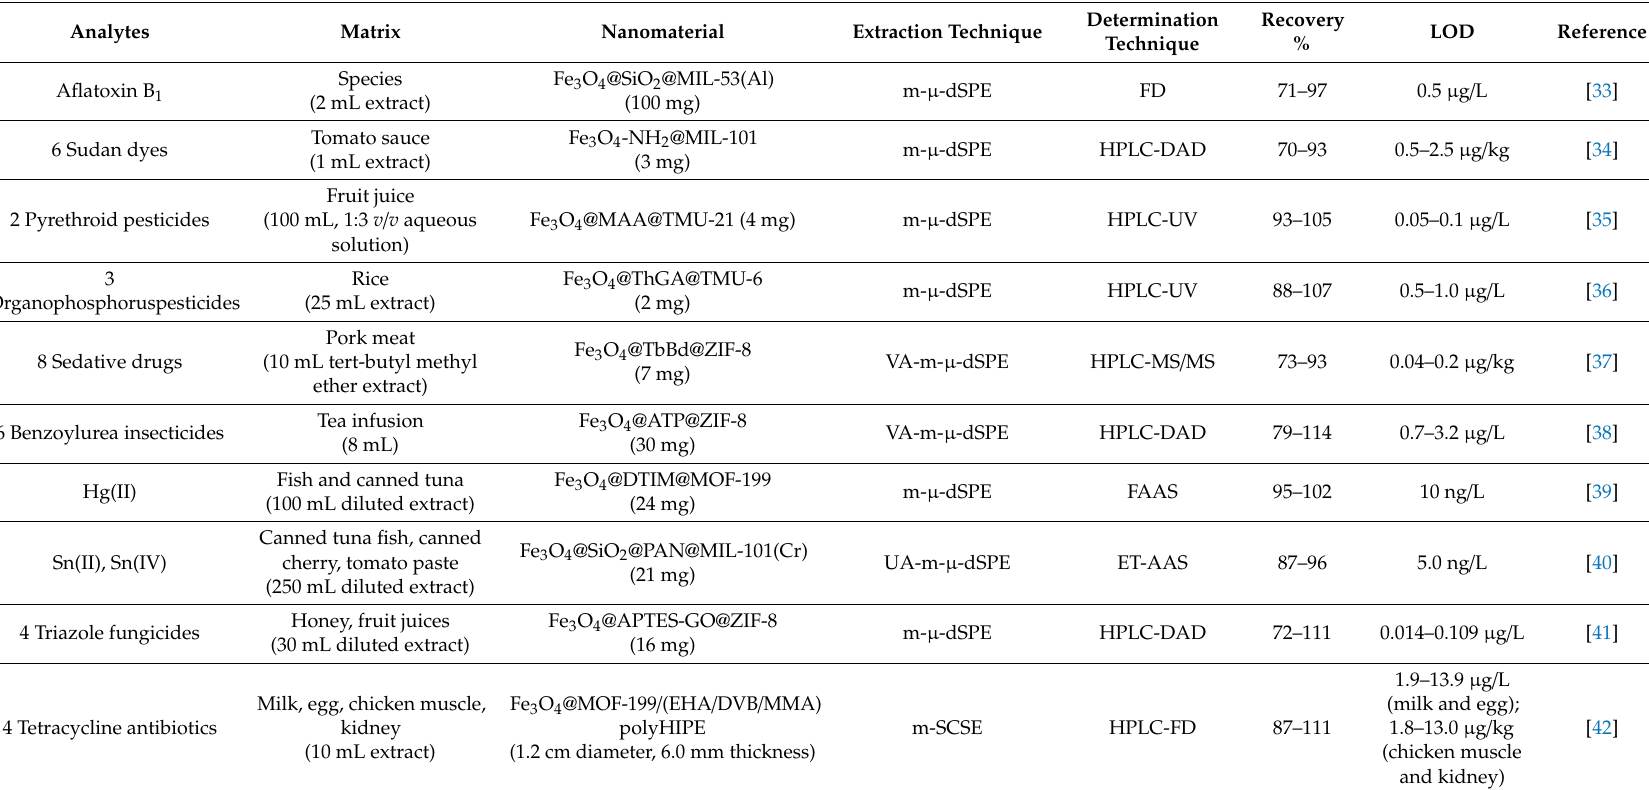
Table 2. Recent applications of magnetic metal-organic frameworks as extraction sorbents in food